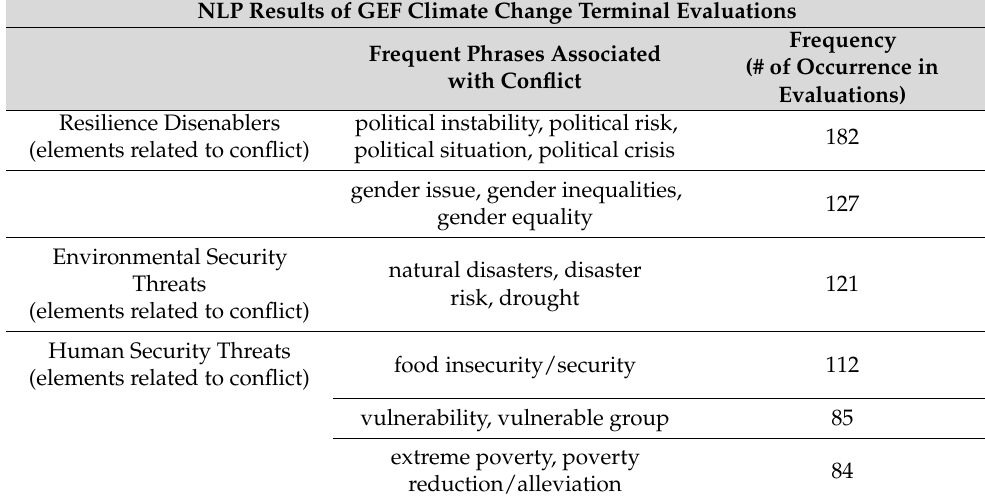
Table 1. Phrases frequently associated with conflict in climate change project evaluations.